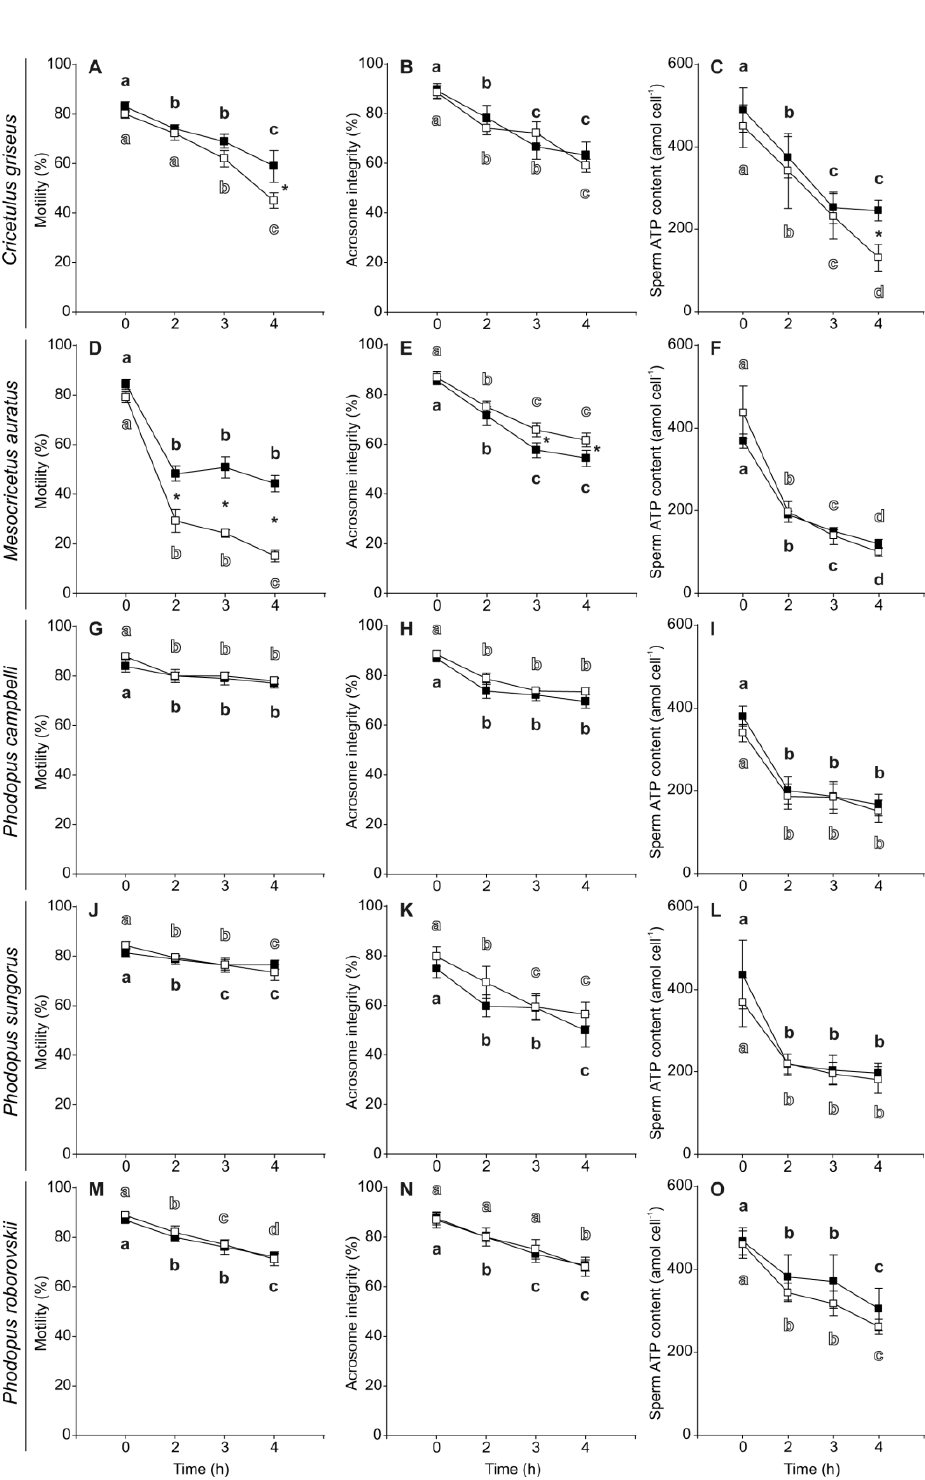
Figure 2. Changes in motility, acrosome integrity, and ATP content in spermatozoa from five hamster species during incubation without or with penicillamine, hypotaurine and epinephrine (PHE). Spermatozoa were collected in medium with (black squares) or without PHE (white squares) and incubated at 37 ◦ C under air for up to 4 h. ( A , D , G , J , M ) Percentage of motile sperm. ( B , E , H , K , N ) Percentage of spermatozoa with an intact acrosome. ( C , F , I , L , O ) Sperm ATP content (amol × cell − 1 ). Values are means ± standard errors. Different letters between times of incubation for the same treatment indicate statistically significant differences ( p < 0.05) in a DGC post-hoc test. Asterisks indicate statistical differences ( p < 0.05) between treatments for the same time in a DGC post-hoc